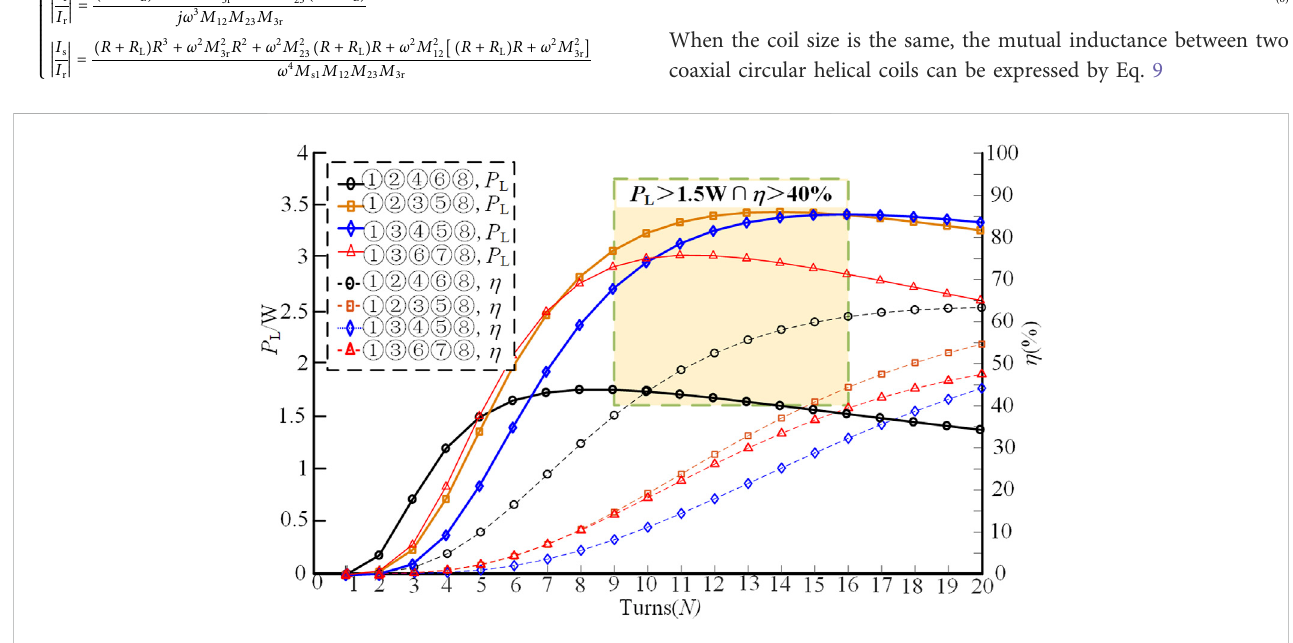
FIGURE 4 The performance of the three-relay coil WPT system varies with N or